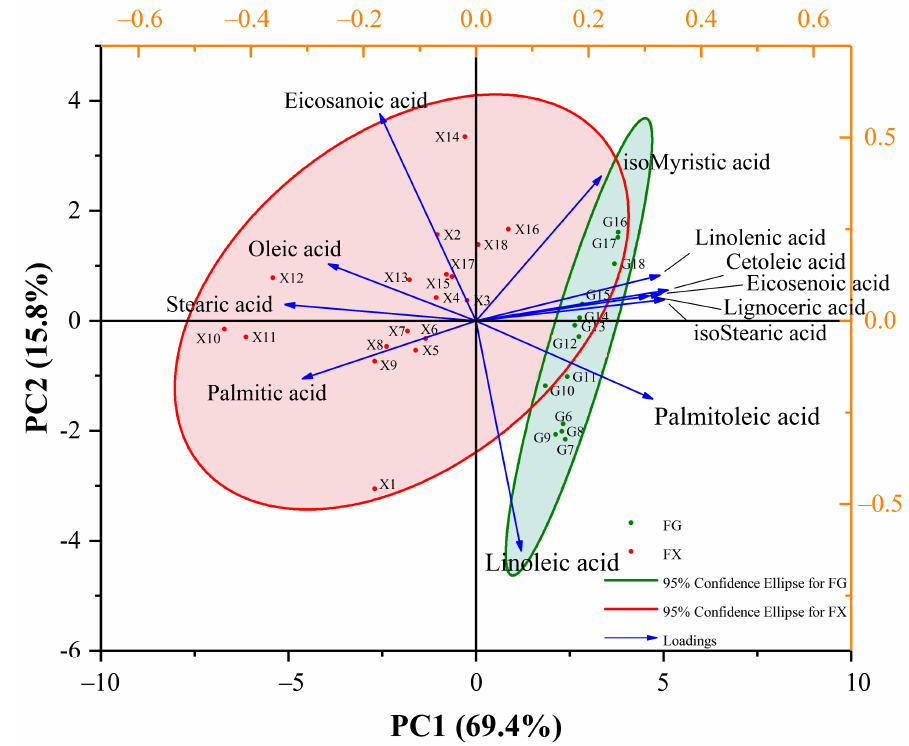
Figure 3. Principal component analysis (PCA) of fatty acid composition for FG and FX samples under 4 ◦ C cold